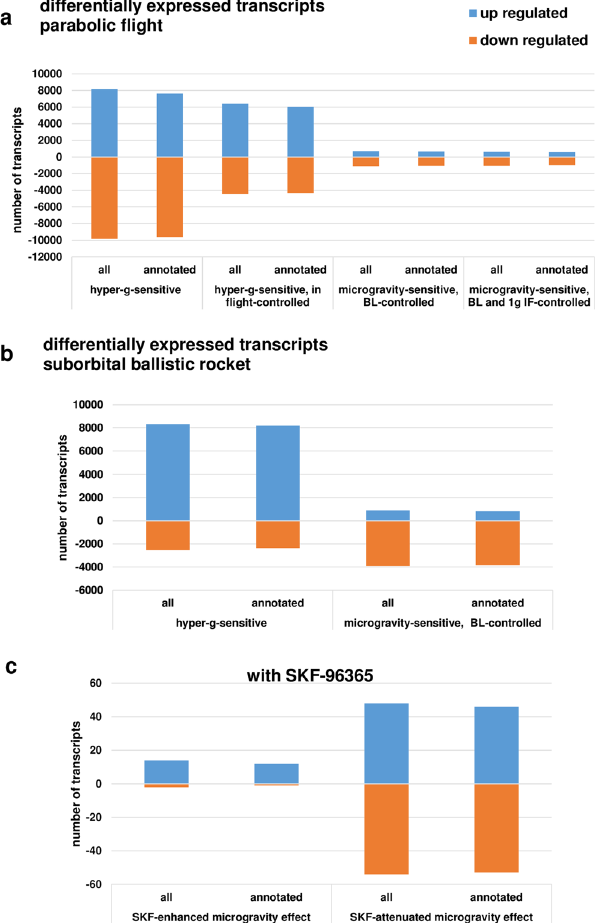
Figure 4. Distribution of differentially expressed transcripts. ( a ) Hyper- and microgravity-sensitive transcripts identified for the 19 th DLR Parabolic Flight Campaign. ( b ) Hyper- and microgravity sensitive transcripts identified for the TEXUS-49 suborbital ballistic rocket campaign, ( c ). SKF-96365-dependent hyper- and microgravity-sensitive